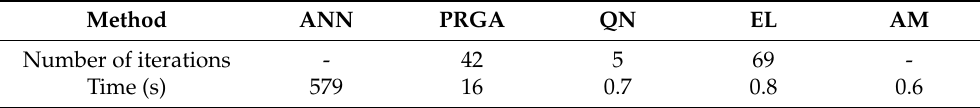
Table 7. The number of iterations and execution time per method.